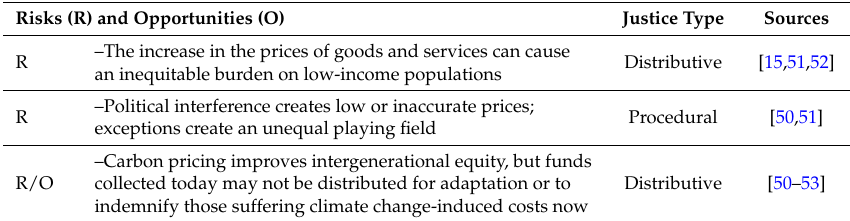
Table 3. Equity and justice potential from carbon pricing.